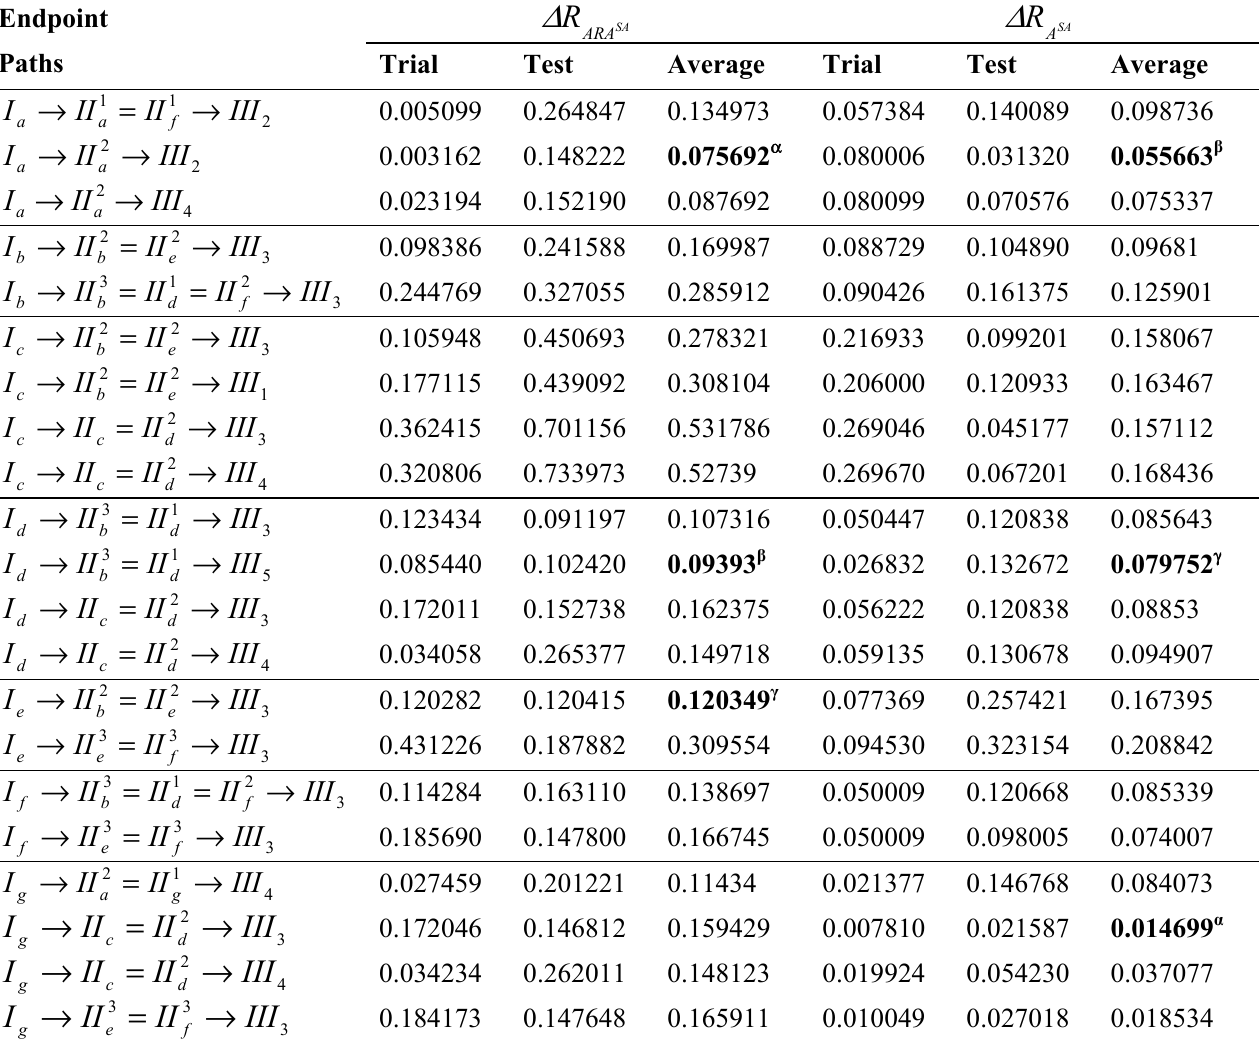
Table 7. Trial-test averages of the correlations’ connected paths between the endpoint models of Table 6, computed using the Euler Equation